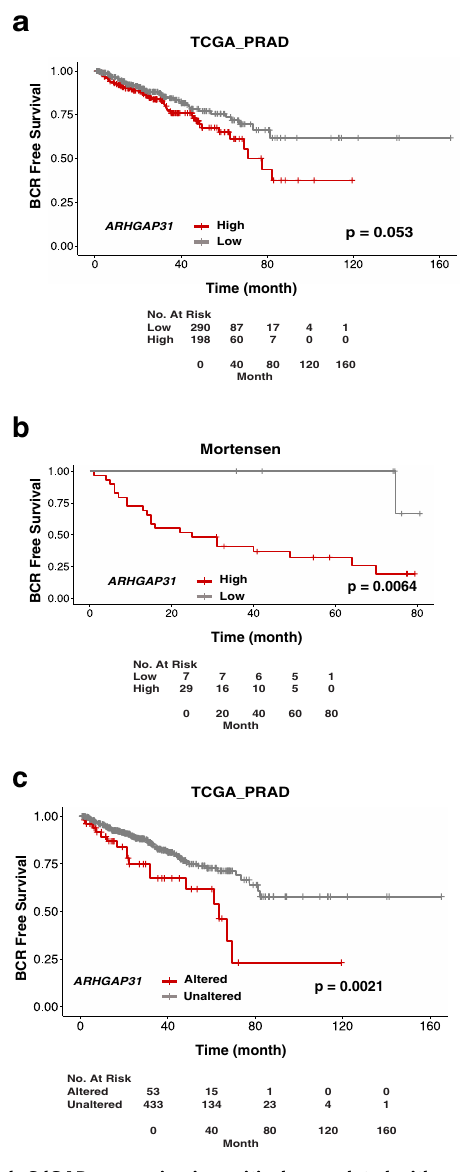
Fig. 1 High CdGAP expression is positively correlated with cancer recurrence. a , b Kaplan – Meier curves of biochemical recurrence (BCR) free survival for TCGA_PRAD ( a n = 488 patients; p = 0.053) and for Mortensen et al. dataset ( b n = 36 patients; p = 0.0064) based on ARHGAP31 transcript levels by using maximally selected rank statistics. c Kaplan – Meier curves of BCR-free survival based ARHGAP31 gene alterations (gain and ampli fi cation) in TCGA provisional data set ( n = 486 patients; analyzed through cBioPortal; p =